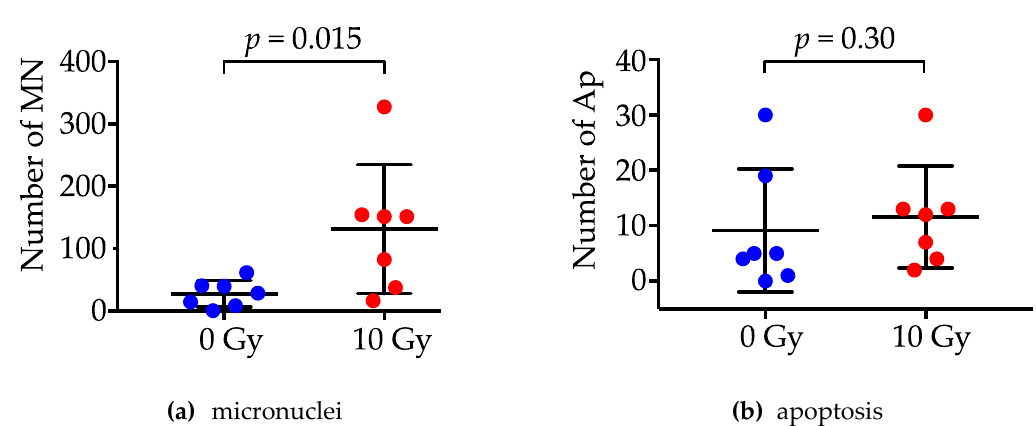
Figure 3. The number of nuclei harboring micronuclei (MN) ( a ) and those undergoing apoptosis (Ap) ( b ) pre-radiotherapy or after 10 Gy RT. p values were assessed by the paired non-parametric Wilcoxon test.